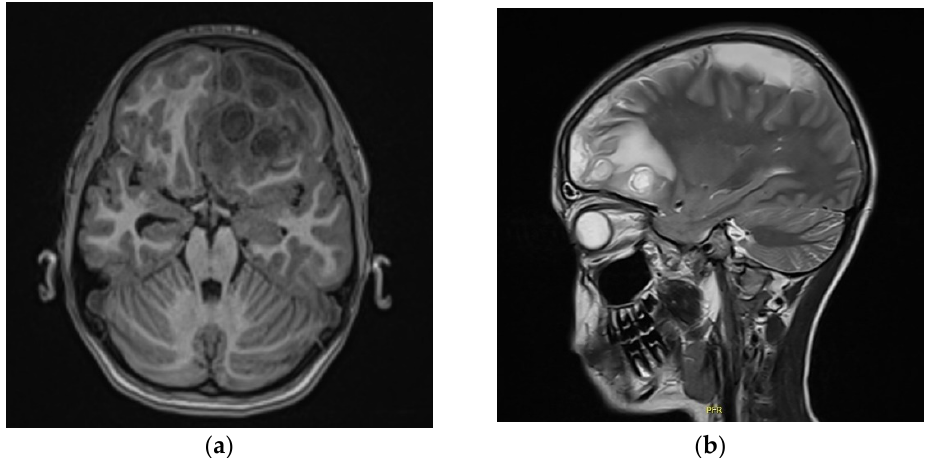
Figure 2. Magnetic resonance imaging (MRI) of the head on 28 December 2021 revealed: ( a , b ) significant progression of brain abscesses with edema and mass effect leading to displacement of midline structures at the right side.